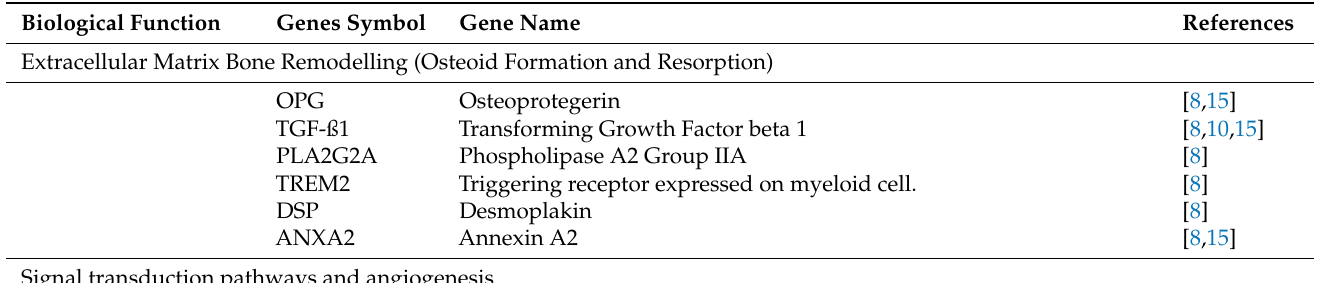
Table 3. Differentially expressed genes (DEG’s) according to biological mechanism in high grade